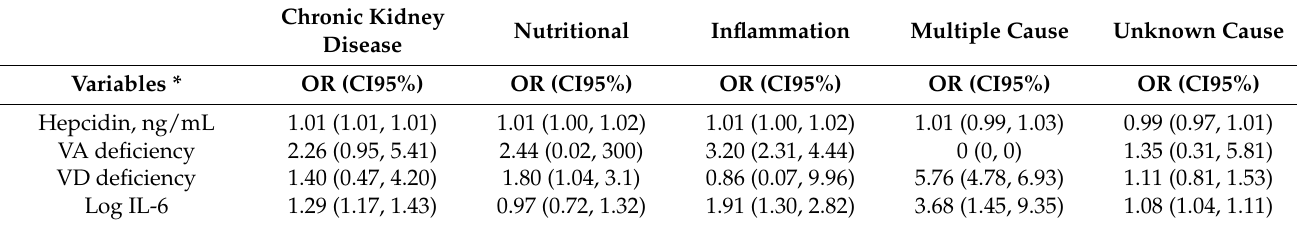
Table 5. Multinomial regression model of variables associated with each cause of